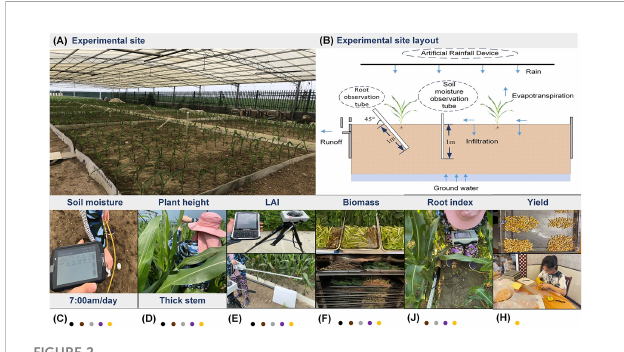
FIGURE 2 (A) experimental site and (B) experimental site layout and (C) soil moisture monitoring and (D) plant height and thick stem monitoring and (E) LAI monitoring and (F) biomass monitoring and (J) root monitoring and (H) yield monitoring.